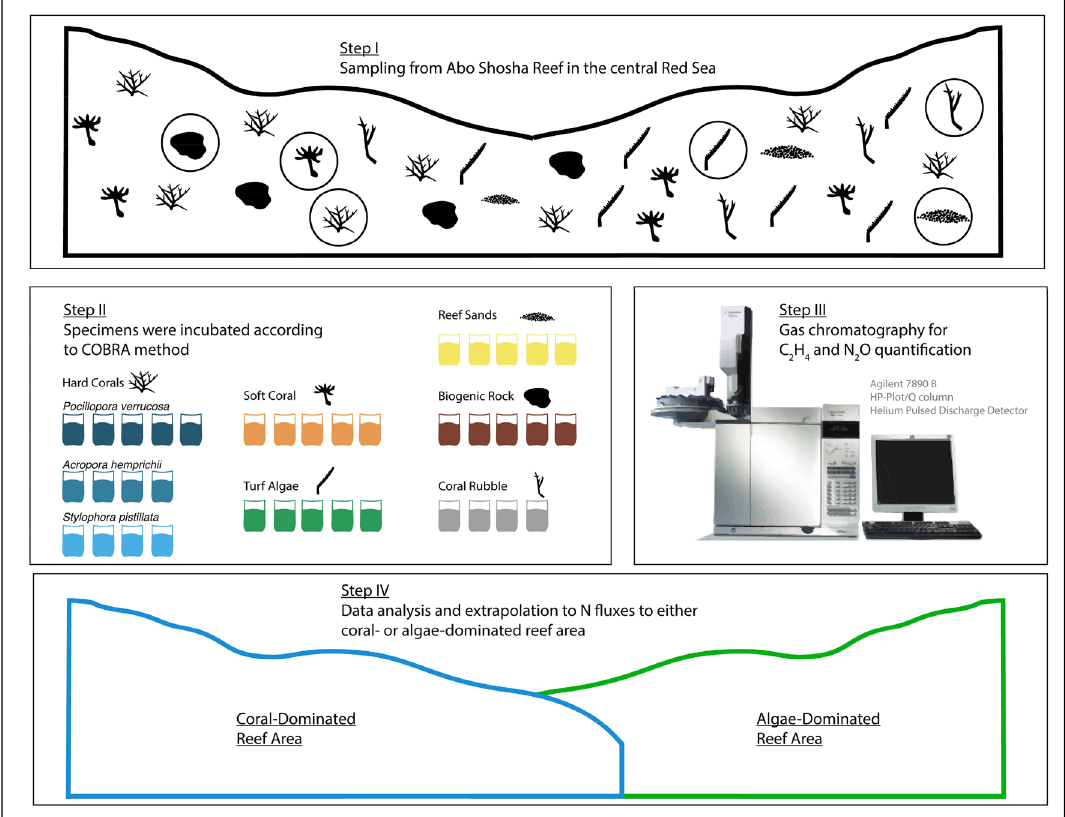
Figure 5. Stepwise illustration of sampling, data acquisition and analysis. Step I illustrates sampling of specimens randomly from the overall reef area (i.e., regardless of coral- or algae-dominated area). Afterwards (step II), all specimens were incubated according to the COBRA method 74 with the displayed replication. Gas samples were taken for ethylene (C 2 H 4 ) and nitrous oxide (N 2 O) measurements via gas chromatography (step III) for N cycling rate quantifications. Obtained data were used for extrapolation to N fluxes to either coral- or algae-dominated reef areas (step